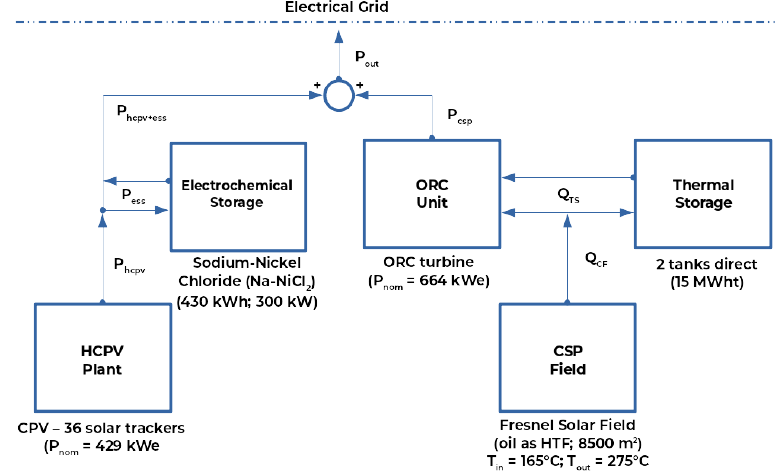
Figure 2. Block diagram of Ottana solar facility used as a case of study.